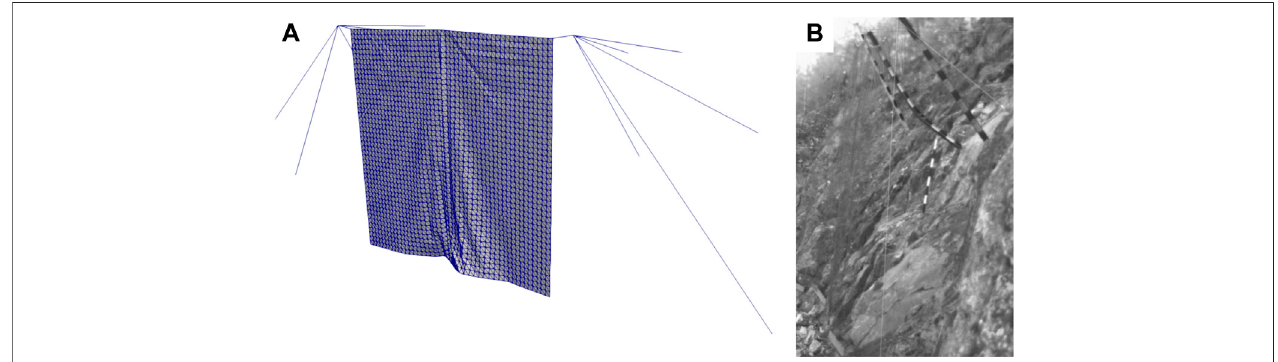
FIGURE 8 | Deformation panel after dead-load equilibrium (before impact). (A) Simulation. (B) Experiment photographed just before impact.